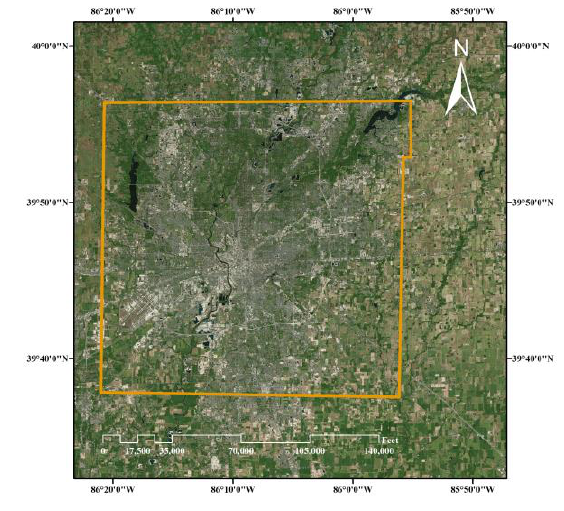
Figure 2. Location of study